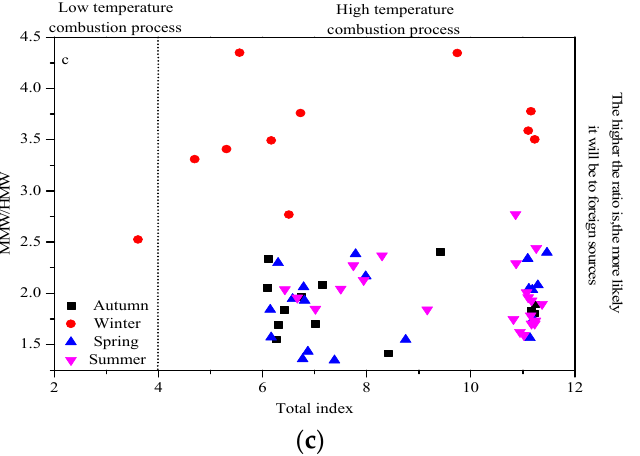
Figure 9. Seasonal variations of ratios of Flu/(Flu+Pyr) versus Ant/(Ant+Phe) ( a ) and Bap/(Bap+Chry) versus Icdp/(Icdp+Bghip) ( b ) and MMW/HMW versus the total index ( c ) in Urumqi.